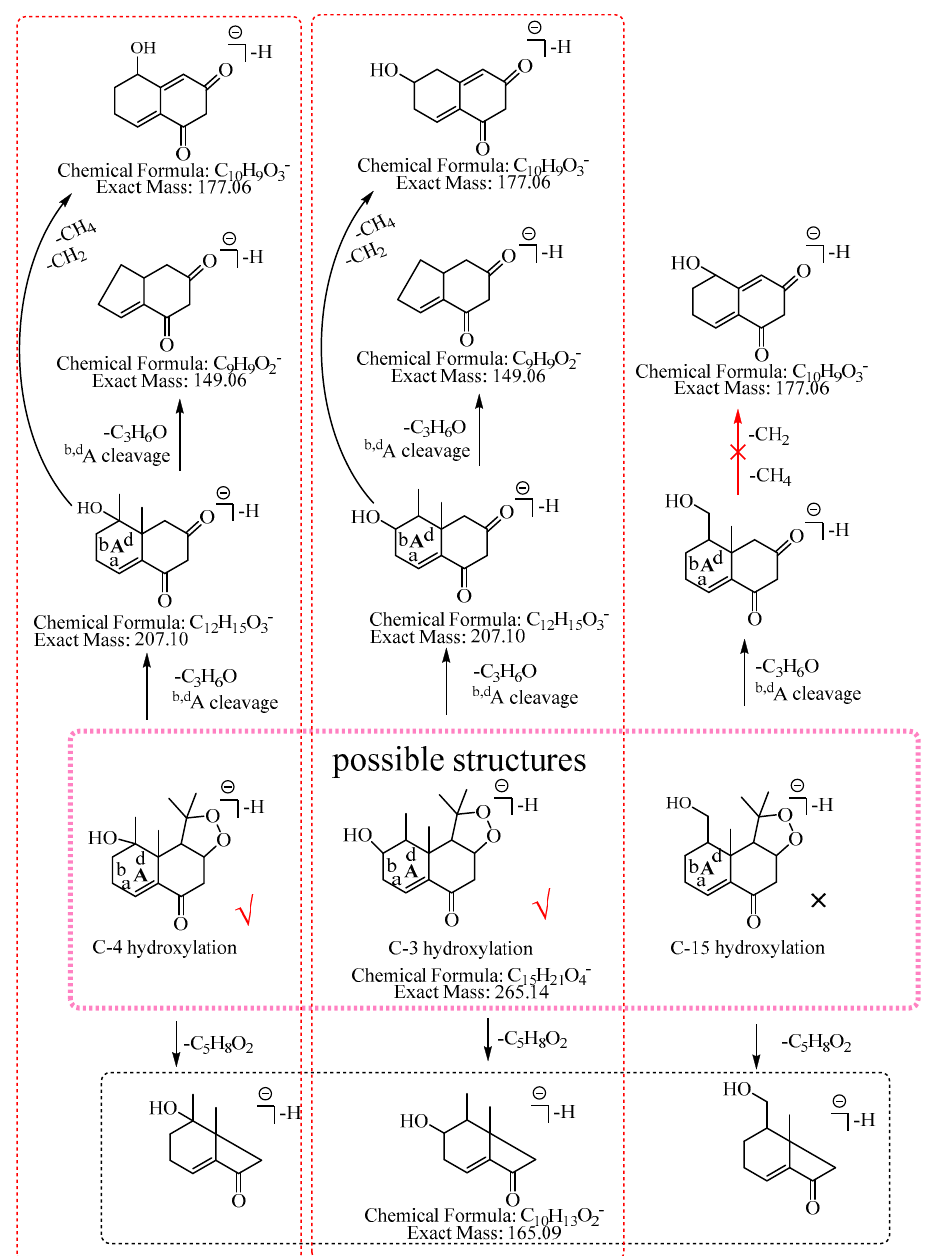
Figure 7. The proposed fragmentation pathways of M5 (3-hydroxyl nardosinone or 4-hydroxyl nardosinone). “ √ ” represents the possible structure. “×” represents the impossible structure. The pink rim represents the possible structures; A represents the hexatomic ring. The red rims represent the most possible fragmentation pathways.